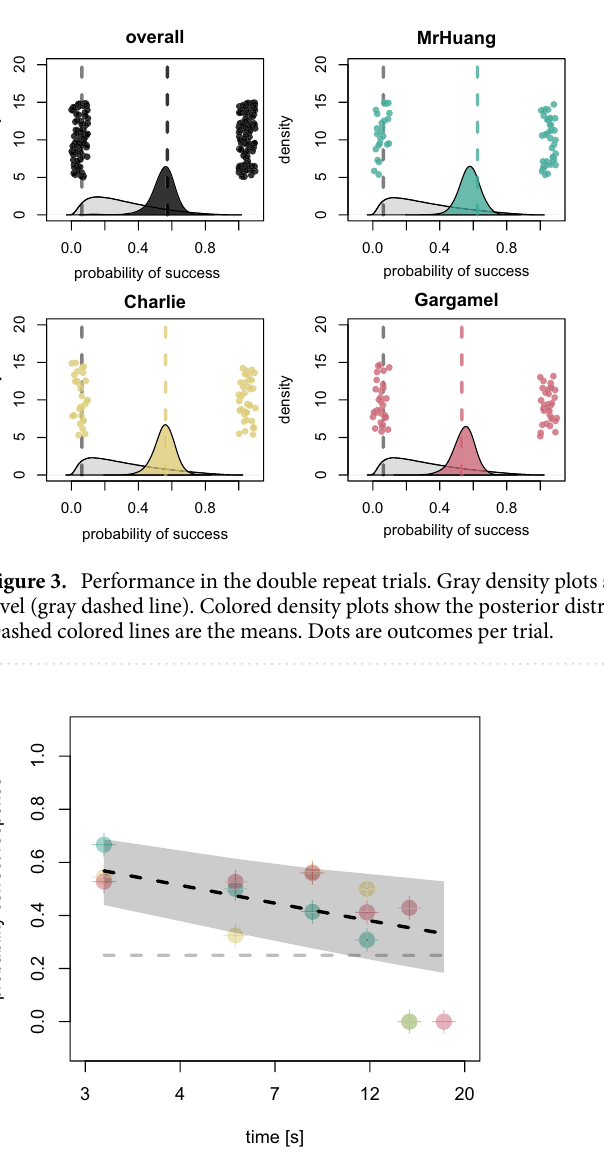
Figure 4. Performance in the delayed repeat test. Colored dots are average performance per delay and individual (green—Mr Huang, yellow—Charlie, red—Gargamel). Dashed line is the predicted performance and gray shaded area the 89% PI.